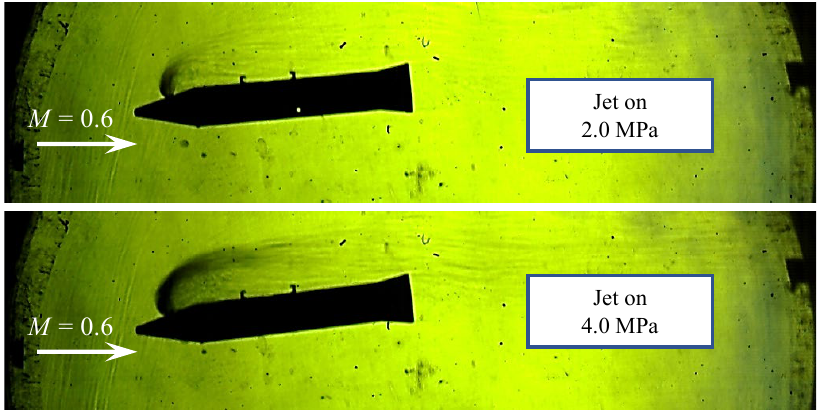
Figure 17. Interaction between jet region, jet flow, and wind tunnel flow at different pressures.